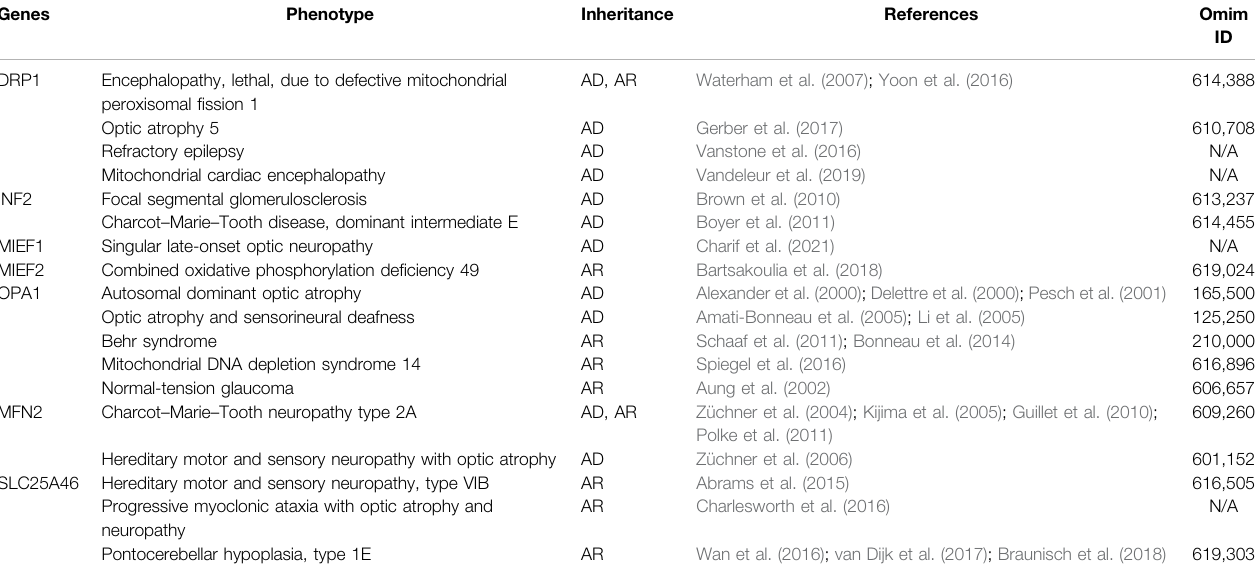
TABLE 1 | Primary disorders caused by mutation of mitochondrial dynamic – regulating